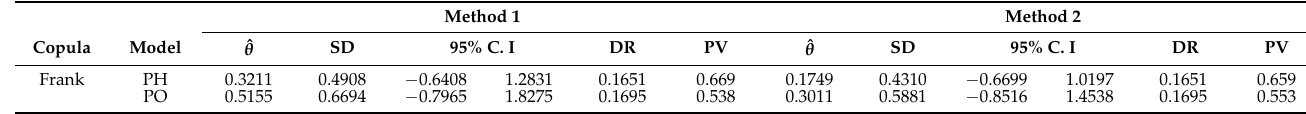
Table 9. The analysis for the retirement center data.